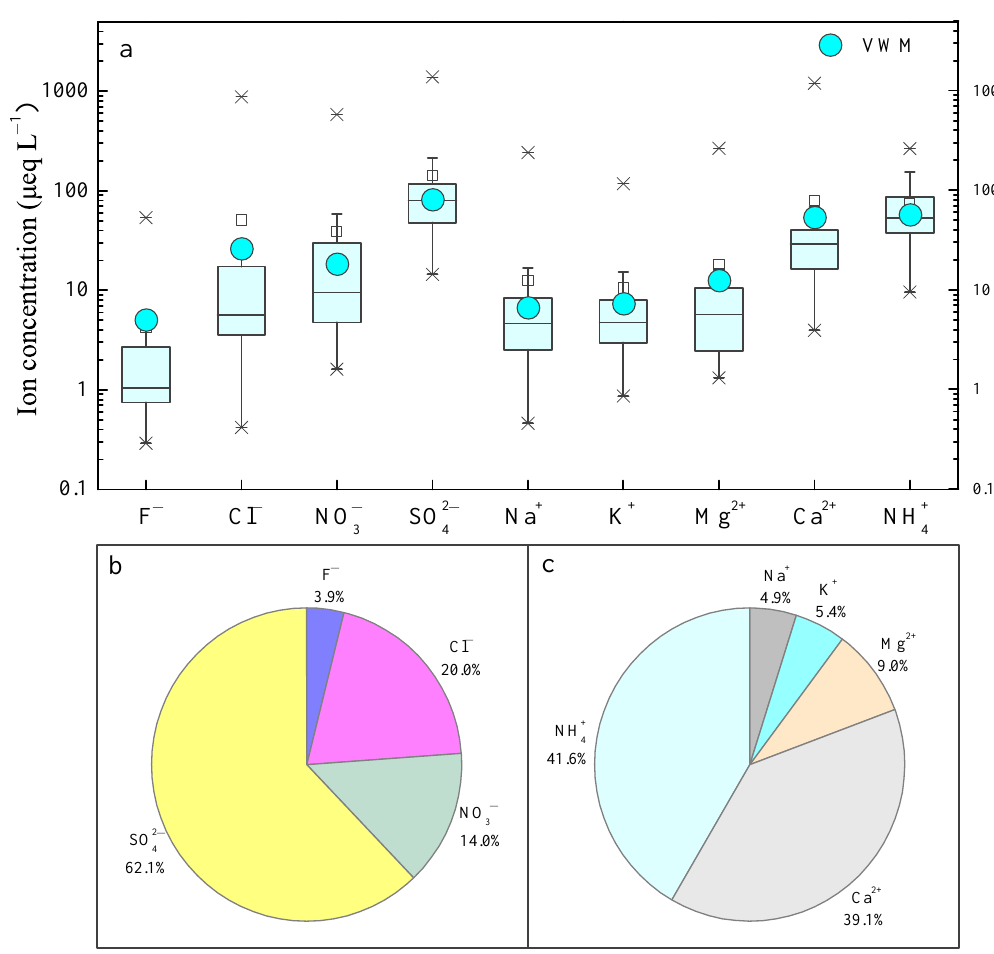
Figure 4. ( a ) Overview of rainwater ion concentrations ( µ eq L − 1 ), ( b ) rainwater anion composition percentages, and ( c ) rainwater cation composition percentages from 2007 to 2014 in the MNKFP. VWM: volume-weighted